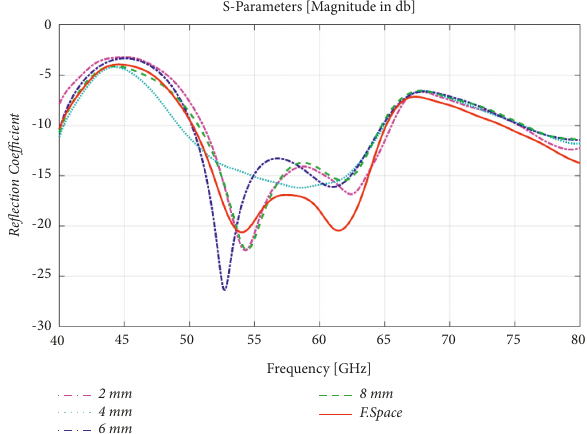
Figure 40: Return loss comparison of the 1 × 2 array antenna for different distances.